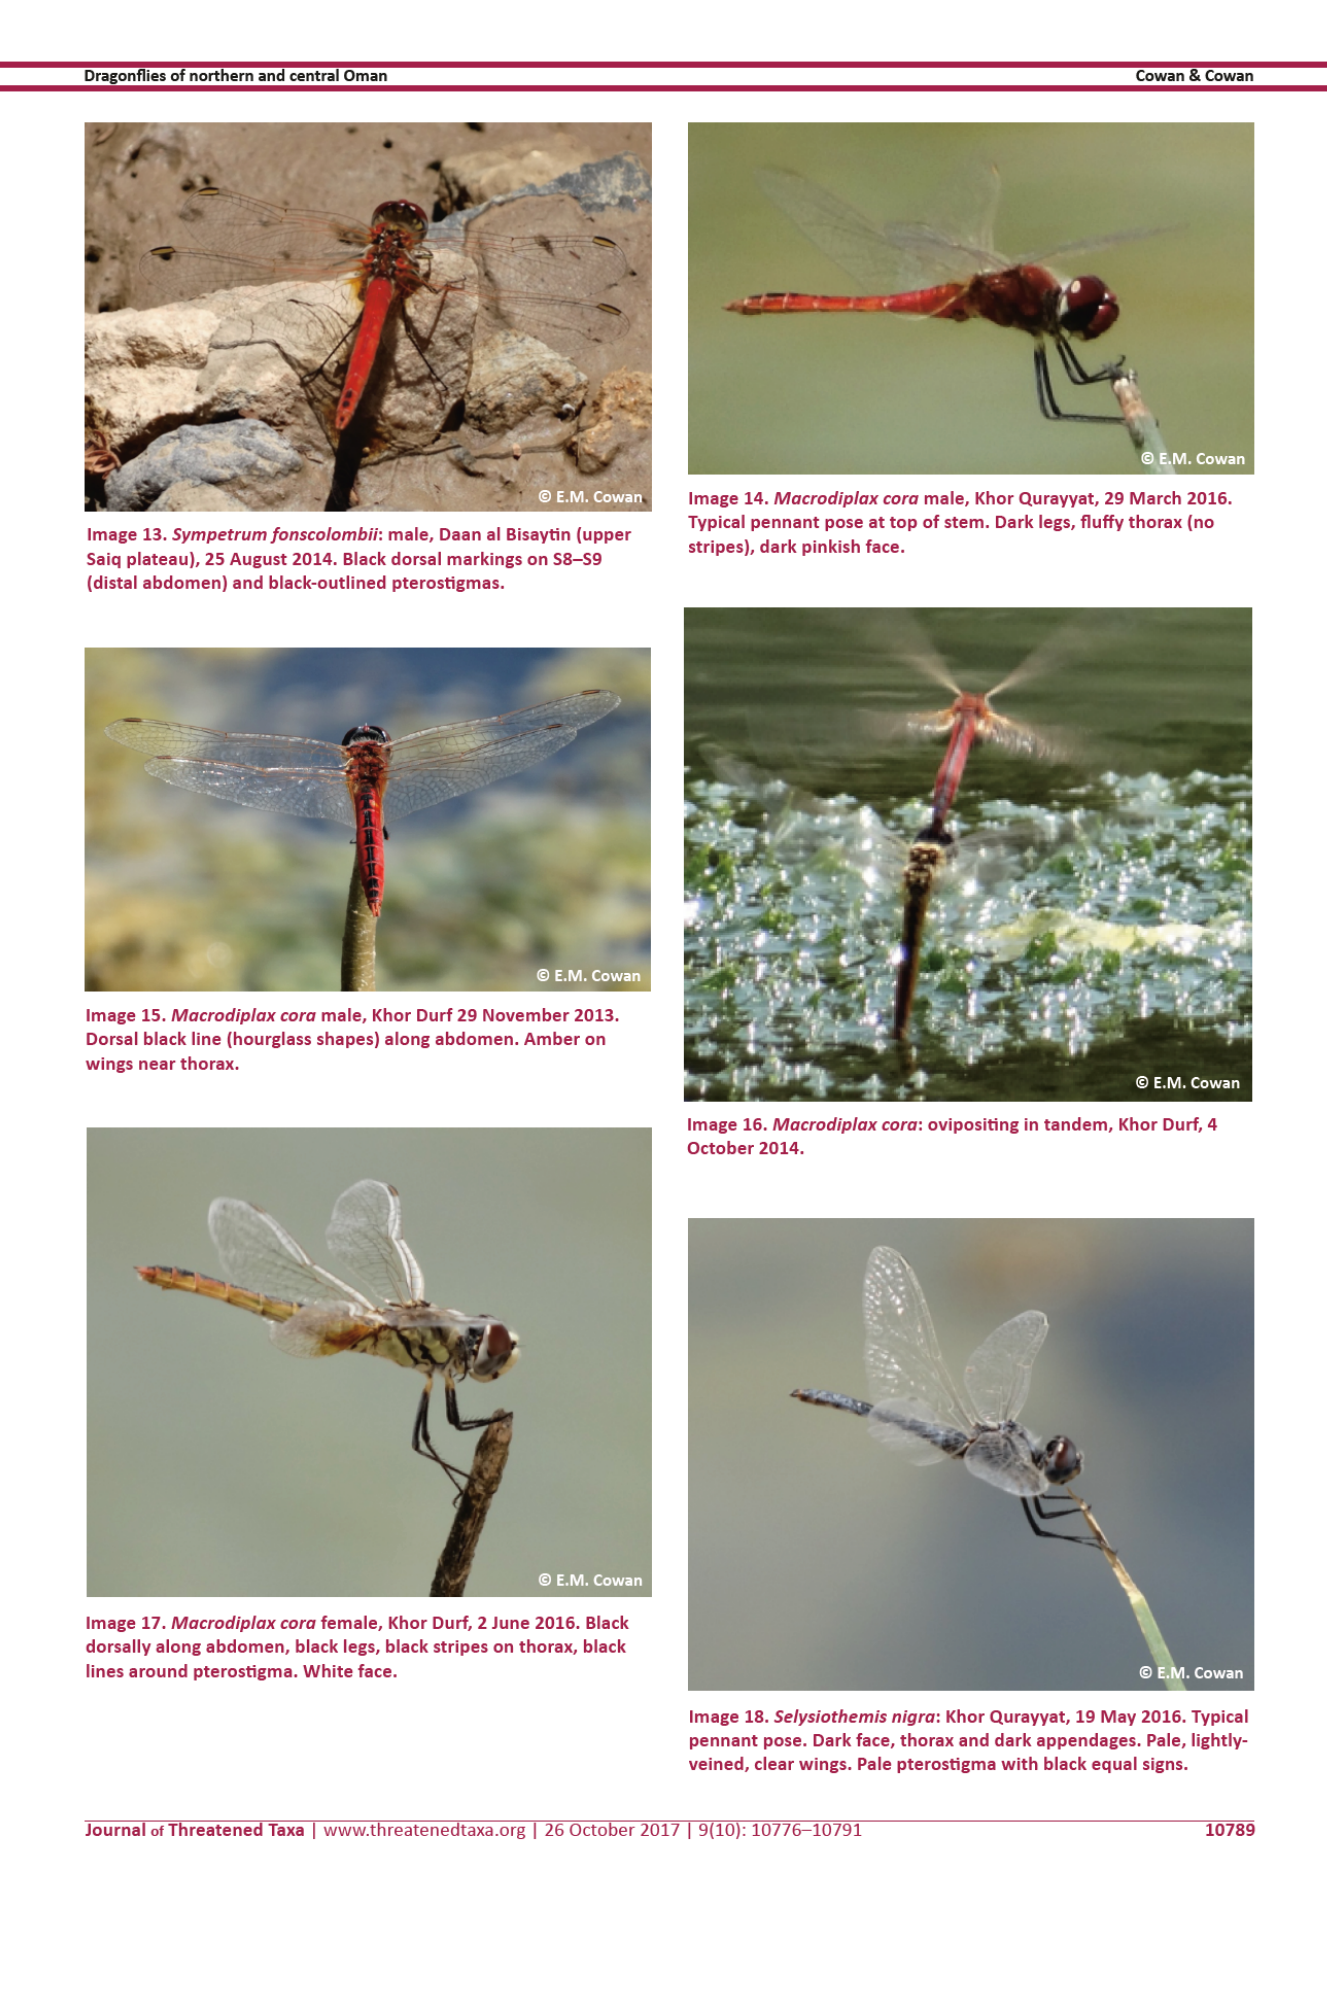
Image 18. Seflysfiofthemfis nfigra: Khor Qurayyaft, 19 May 2016. Typficafl pennanft pose. Dark face, fthorax and dark appendages. Pafle, flfighftfly- vefined, cflear wfings. Pafle pfterosfigma wfifth bflack equafl